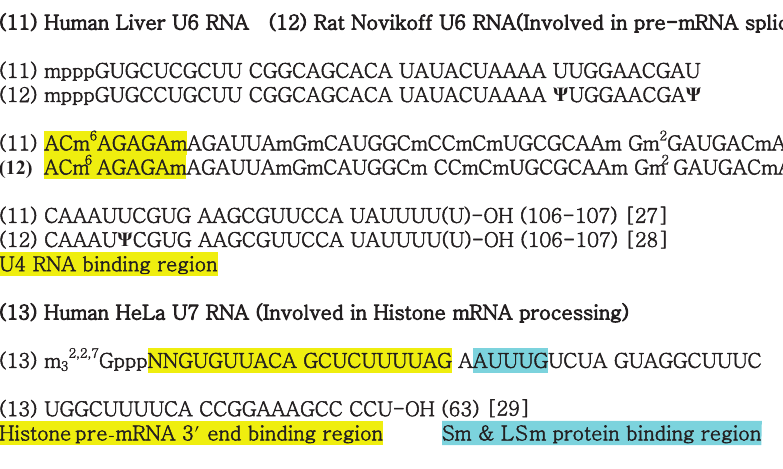
snake venom phosphodiesterase and alkaline phosphatase. The nucleosides produced were separated on HPLC (high pressure liquid chromatography) [strongly basic cation exchange (quaternary amine)]. As shown in Figure 18, the amount of nucleoside ratio was 1.0, 1.2, 1.2, 0.7, and 0.9 for Am, A, Um, m 3 2,2,7 G, and C, respectively, for U1 5 (cid:2)